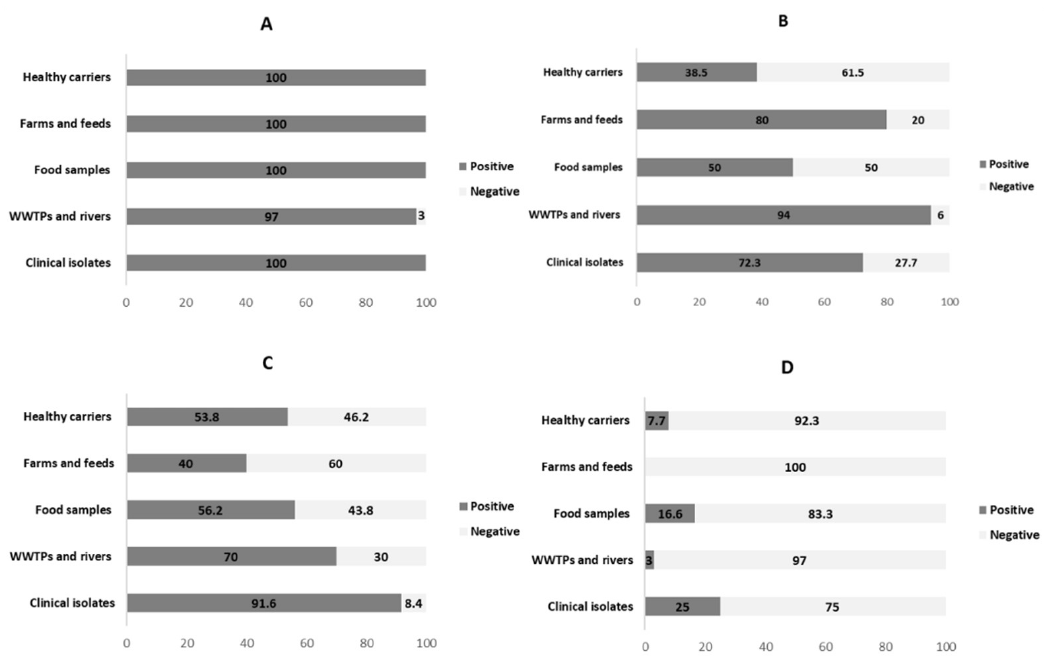
Figure 2. Prevalence (percentages) and distribution of insertion sequences in ESBL-producing E. coli according to their origin. ( A ) IS 26 ; ( B ) IS Ecp1 ; ( C ) IS 903 ; ( D ) IS CR1 .